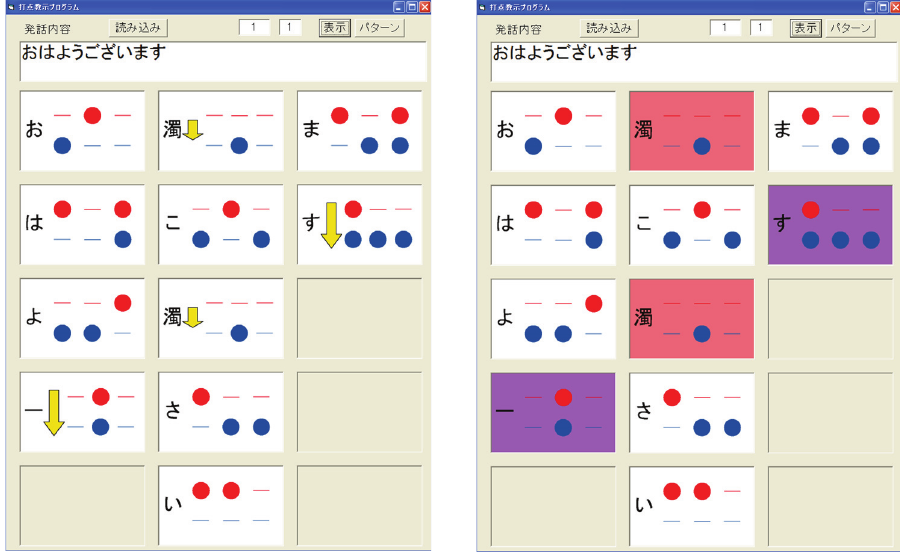
Figure 27: Examples of patterns for teaching unskilled people how to express emotions using Finger Braille.